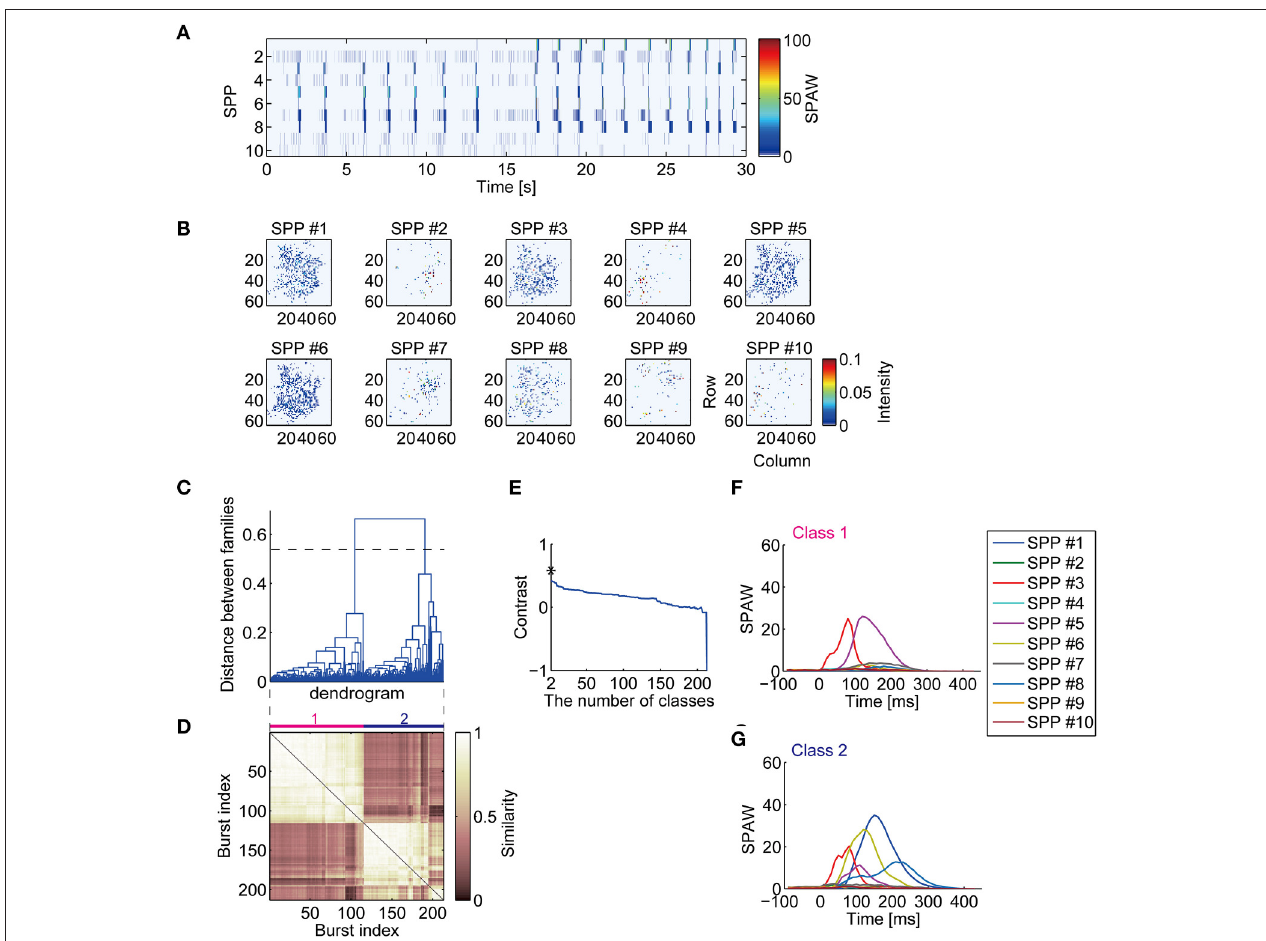
FIGURE 2 | Decomposition of high-dimensional neuronal activity and classification of synchronized burst patterns. (A) Low-dimensional activity of the neuronal network represented with sub-population activation weights (SPAWs). The same period of Figures 1C,D is illustrated. (B) Sub-population patterns (SPPs) of spontaneous activity of cultured cortical neurons obtained with NMF. The SPPs are shown as corresponding to recording electrodes configuration. (C) A dendrogram represents a process of hierarchical grouping of BFMs. The dotted horizontal line indicates a selected level of the grouping. (D) A similarity matrix of sub-population activation weights during synchronized bursts. (E) A contrast function for the dendrogram shown in (C) . Asterisk indicates a maximum peak of the function. (F , G) Mean SPAWs within classified burst classes.